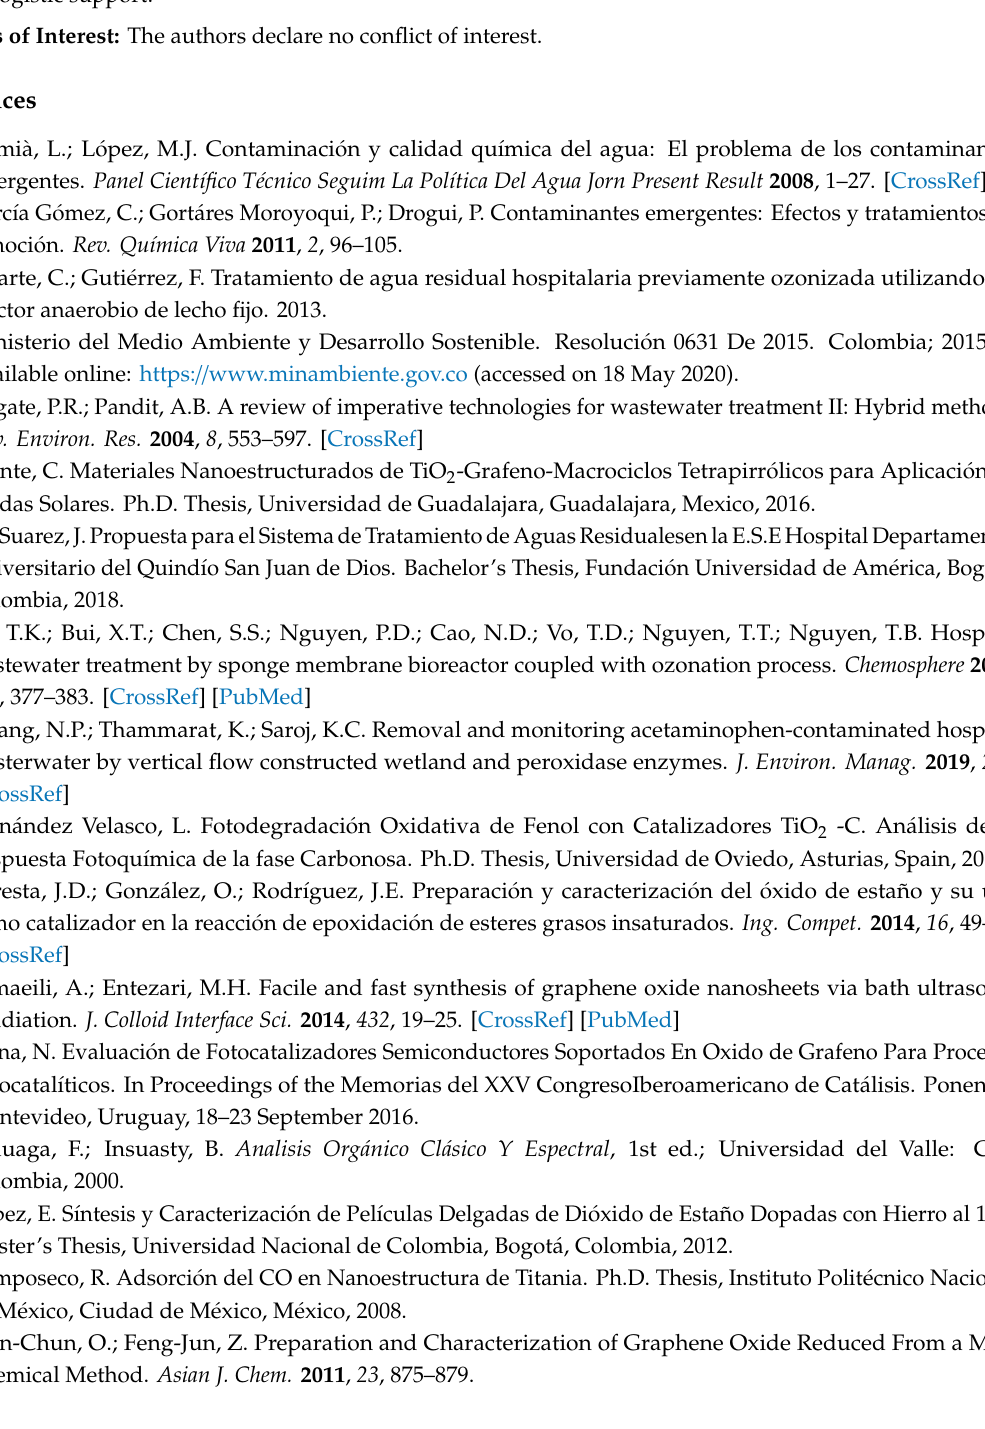
Figure S1. Di ff use reflectance spectra of TiO 2 and TiO 2 -GO catalysts; Figure S2. Di ff use reflectance spectra of SnO and SnO-GO